Question: Write a descriptive caption for this figure.
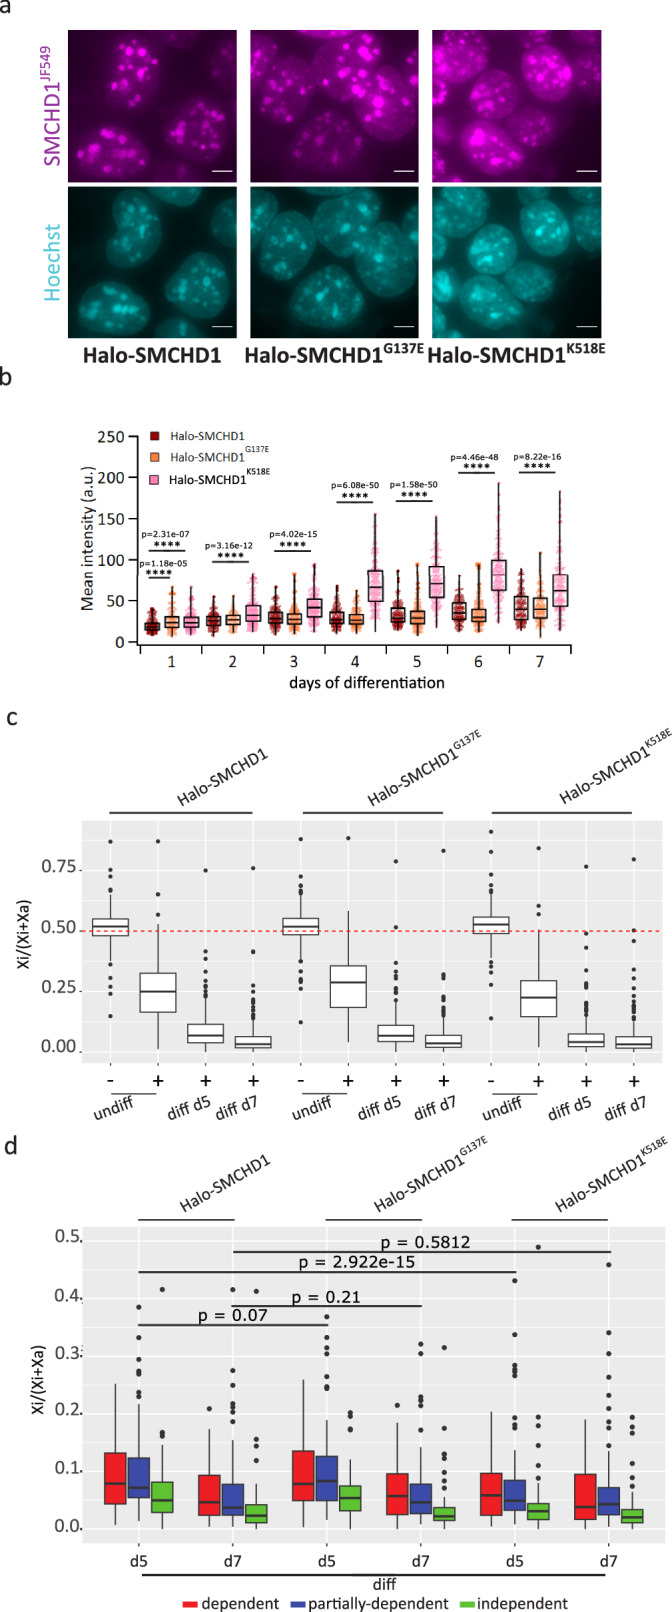
Answer: Gain-of-function mutations in the SMCHD1 GHKL ATPase can enhance Xi recruitment and X-linked gene silencing. a Representative live-cell images of indicated mESCs undifferentiated, kept for 24 h with doxycycline. Images are maximum-intensity projections, scale bar − 5 µm. b Quantification of SMCHD1 signal underlying CIZ1 domains in indicated cell lines during 7-day differentiation timecourse. Each dot represents a cell, n = 83-210 (Halo-SMCHD1 (159, 136, 148, 145, 148, 141, 151), K518E (180, 210, 198, 209, 207, 200, 200) for day 1-7, G137E (109) for day 1). Boxplots: centre lines indicate the median, box limits indicate the first and third quartiles and whiskers extend to min/max data points. Statistical analysis was by two-sided unpaired t-test. c Box plot showing allelic gene expression for X-linked genes ( n = 181) in indicated cell lines; uninduced, induced for 24 h with doxycycline or differentiated for 5 or 7 days. The boxes represent one (undiff conditions) or an average of two (Halo-SMCHD1 d5, G137E d5, K518E d5 and d7) or three (Halo-SMCHD1 d7, G137E d7) replicates d Box plot showing allelic X-linked gene ( n = 181) expression in indicated cell lines differentiated for 5 or 7 days, with genes split in three categories according to their dependency on SMCHD1 for silencing 13 . The boxes represent an average of two (Halo-SMCHD1 d5, G137E d5, K518E d5 and d7) or three (Halo-SMCHD1 d7, G137E d7) replicates. Statistical analysis – two-sided paired t test. Boxplots ( c , d ) centre lines indicate the median, box limits indicate the first and third quartiles and whiskers indicate 1.5× the interquartile range (IQR). Source data are provided as a Source Data file.